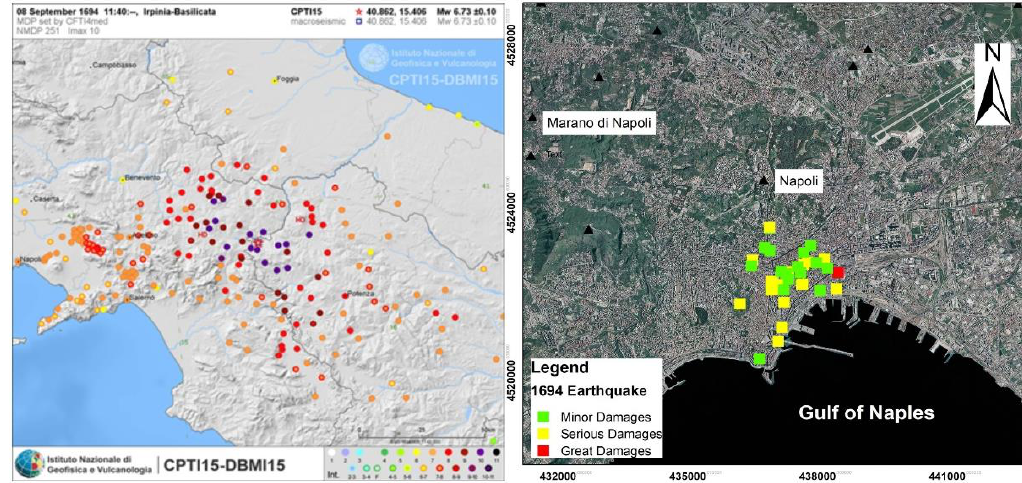
Figure 6. Map of the 1694 MCS macroseismic intensity (modified from [1]) on the left; map of the damage to Naples from the earthquake of 8 September 1694 on the right.